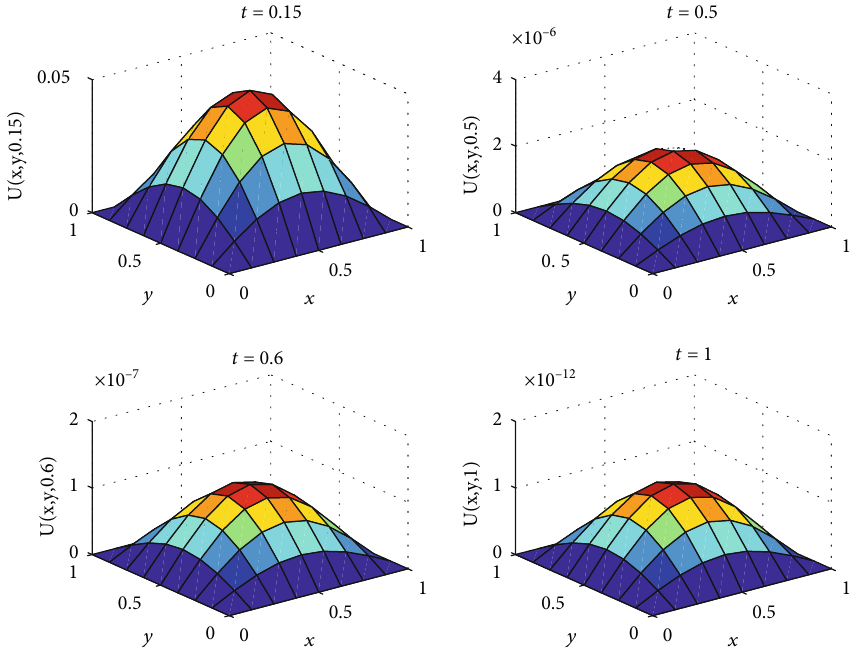
Figure 4: Temperature images at di ff erent times when D = 1 , ε 2 = 0 : 01 , h = 1/16 , and τ = 1/80